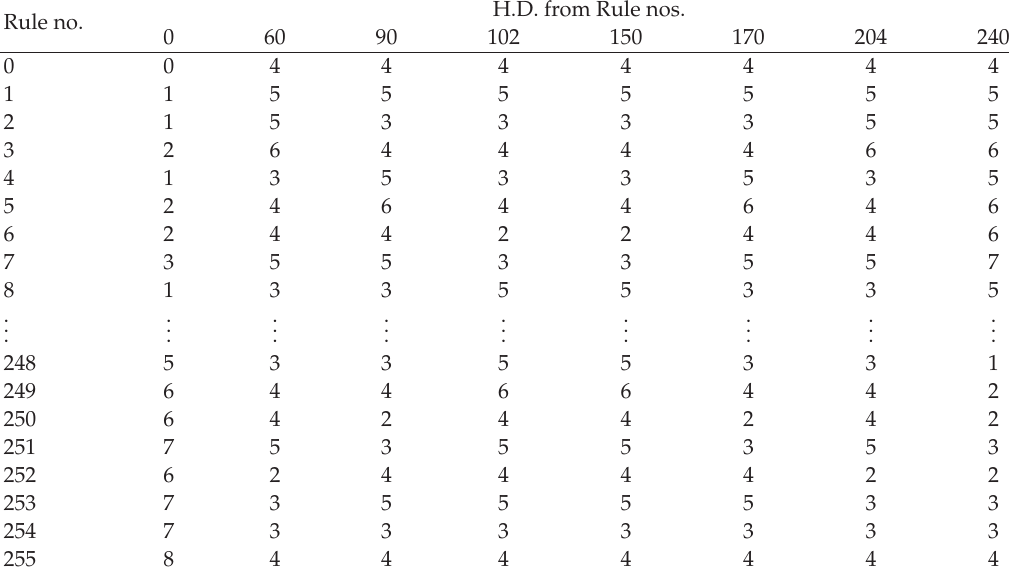
Table 1: H.D.s of three-variable Boolean Functions from linear rules. Rule